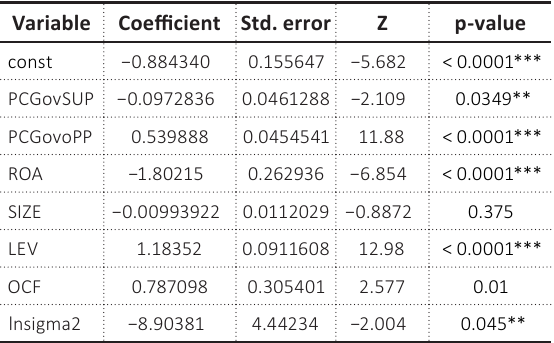
Table 3. Model 2, random effects probit model,